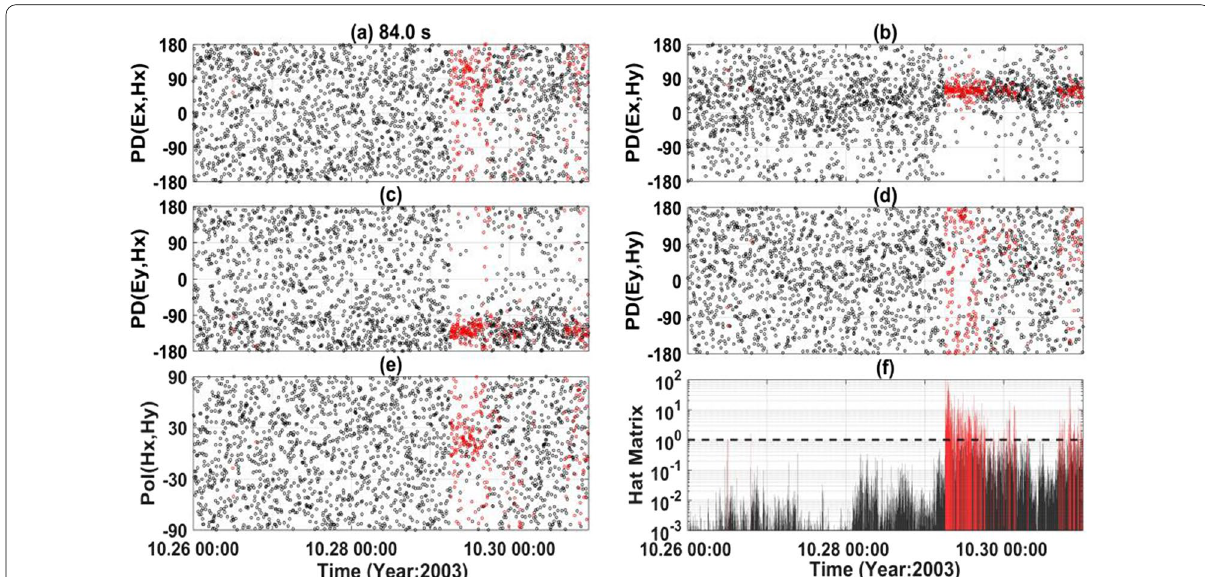
Fig. 7 Evaluation indices in the period of 84 s using the data observed from 00:00 on October 26 to 00:00 on October 31 at site 142. The data in red correspond to the leverage data caused by the storm. a – d Show the variation in PD( E x , H x ), PD( E x , H y ), PD( E y , H x ), and PD( E y , H y ), respectively; e shows the variation in polarization direction for the magnetic field; and f shows the variation in the normalized hat matrix’s diagonal element. There are preferred directions of the phase difference between the orthogonal electric and magnetic fields corresponding to the leverage data, as shown in b and c